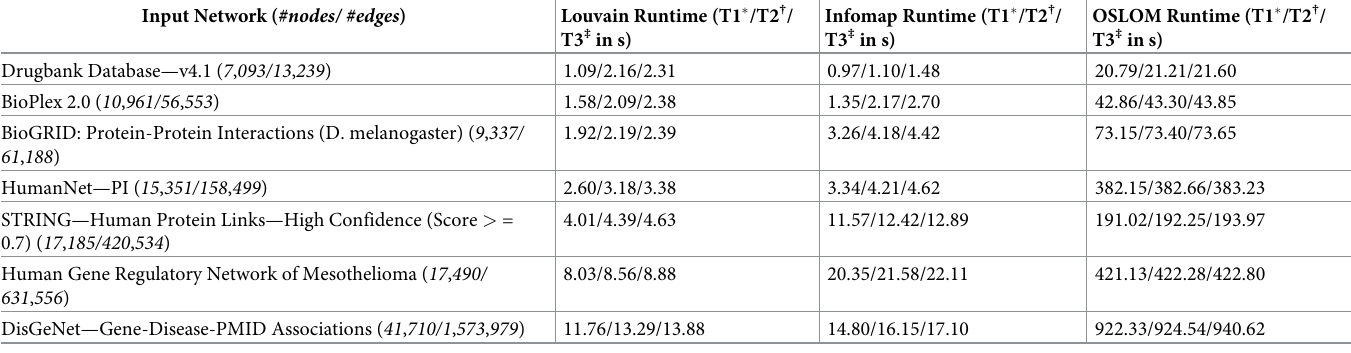
� T1 indicates the time taken by a community detection algorithm inside the CD Service. † T2 indicates T1 plus the network transmission time to and from the CD Service. ‡ T3 indicates T2 plus network creation time in